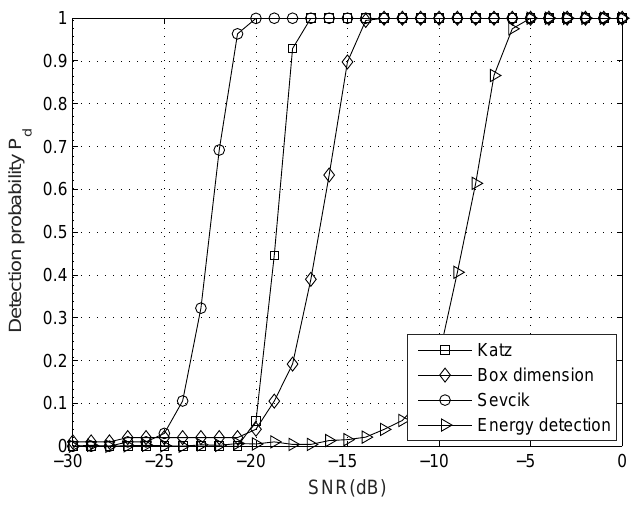
Figure 5. Detection probability comparison of the proposed method with the other three methods. SNR: signal-to-noise